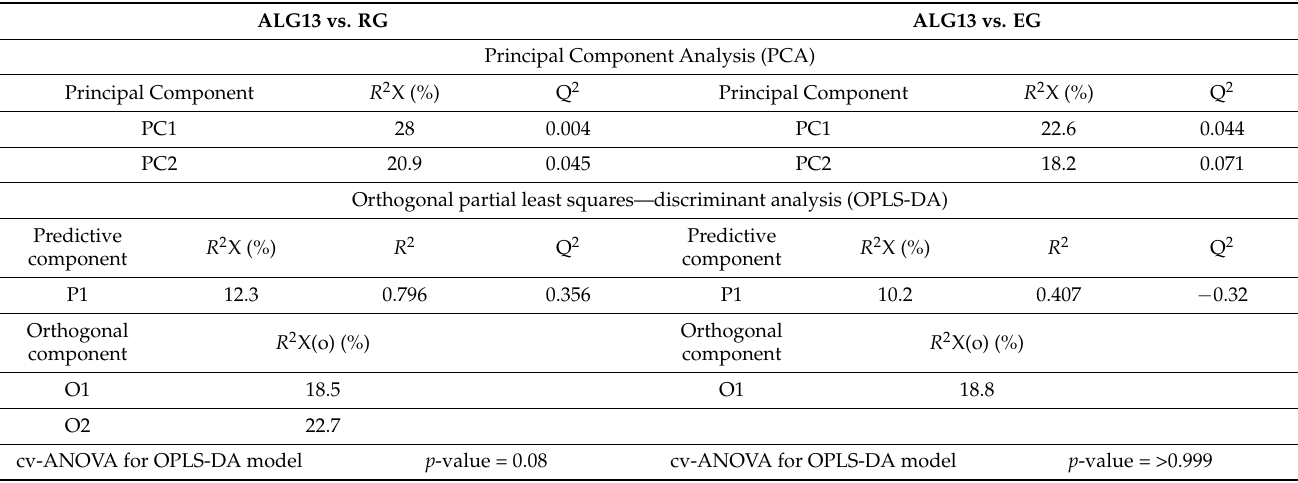
Table 1. Diagnostic parameters of the PCA and OPLS-DA models comparing ALG13 with RG and ALG13 with EG. ALG13 vs. RG ALG13 vs. EG Principal Component Analysis